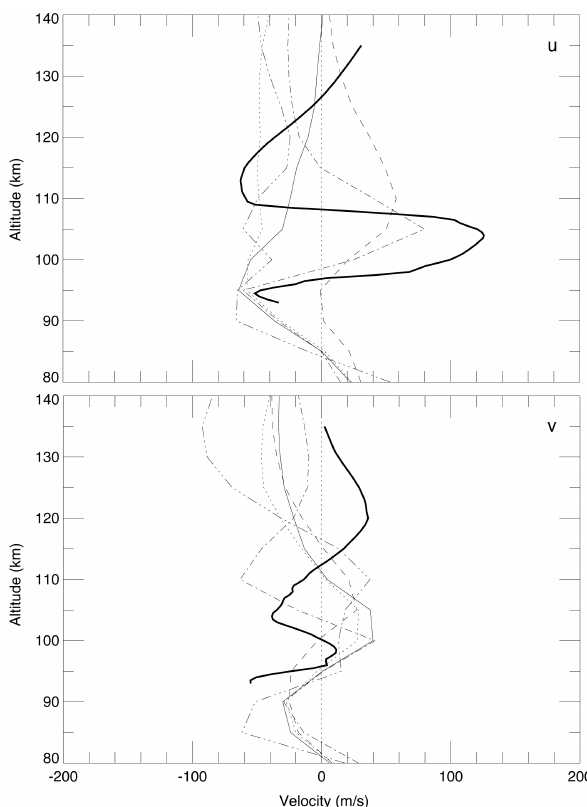
Fig. 9. Zonal (top panel) and meridional (lower panel) chemical release wind profiles obtained at Eglin Air Force Base in Florida at 22:30UT on 3 December 1962 compared with the wind profiles for the nearest grid point and local time from the four TIME-GCM model runs. The wind profiles are shown for fixed forcing (solid line), varying solar and auroral forcing (dotted line), NCEP forcing (dashed line), and doubled height resolution (dot-dash